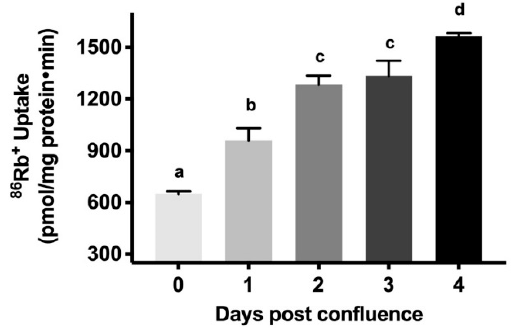
Figure 4. Na-K-ATPase activity as measured by 86 Rb + uptake in IEC-18 cells. Values are represented as means ± SEM, n = 5. Values not sharing common superscripted letters are significantly different at p < 0.01.